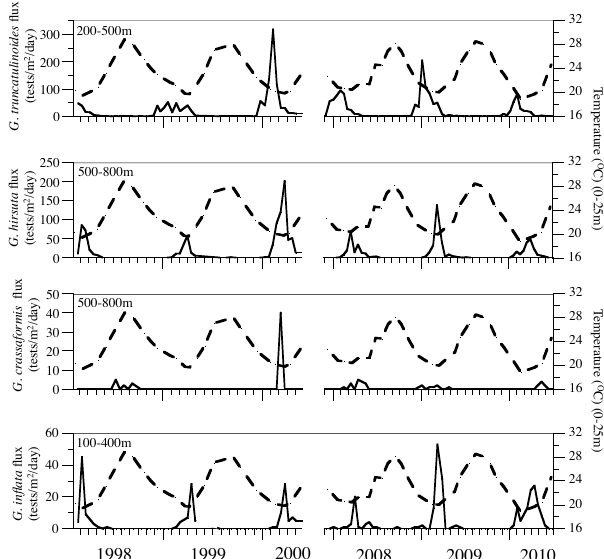
Figure 7. Temporal changes in deeper-dwelling planktonic foraminifera fluxes in the 1500m trap with changes in sea surface temperature (0–25m) for reference. The approximate depth habitat (Anand et al., 2003) is shown in figures. Graphs are ordered accord- ing to seasonal succession.